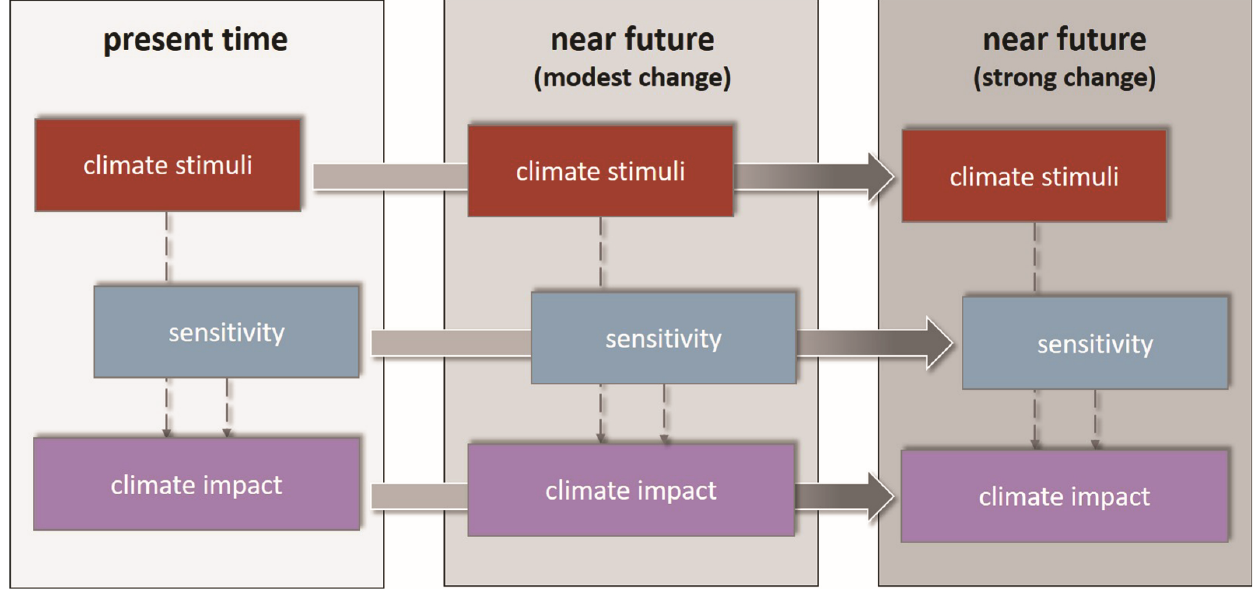
Figure 2. Methodological framework for the CIA. Own figure based on UBA 2015.